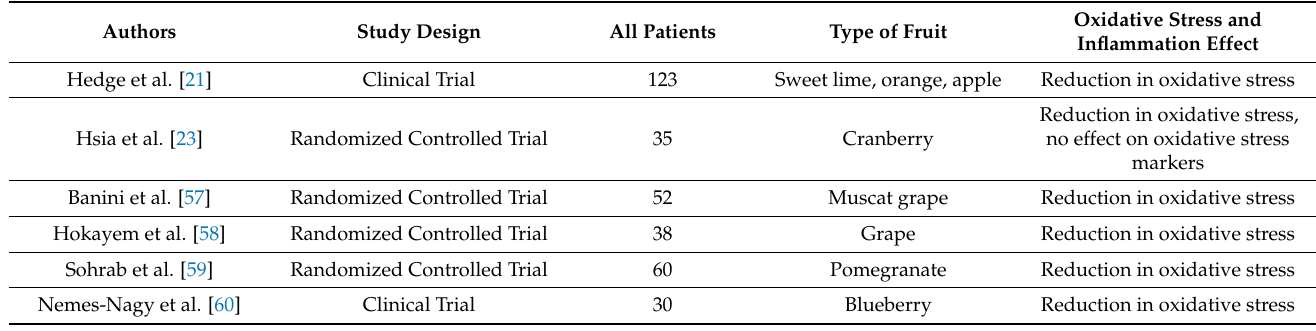
Table 3. Effects of Fruit on Inflammation and Oxidative Stress